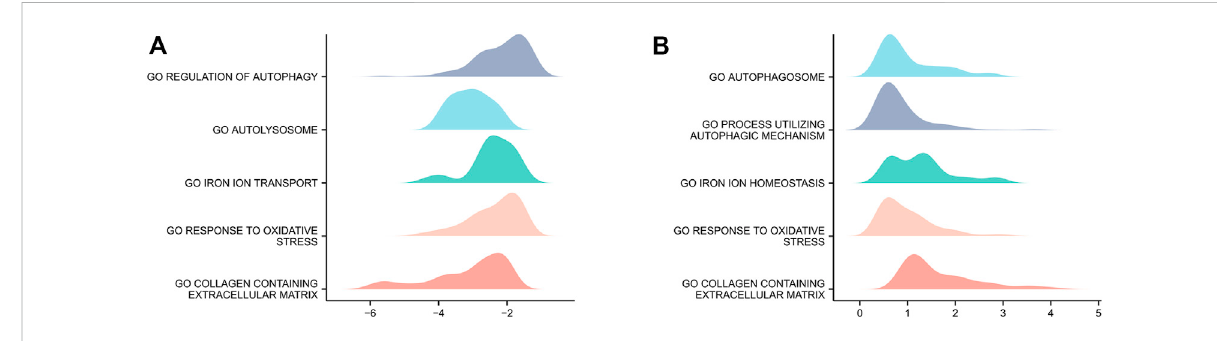
FIGURE 3 GSEA of the two datasets. (A) GSEA of genes in the GSE15227 dataset. (B) GSEA of genes in the GSE23130 dataset.